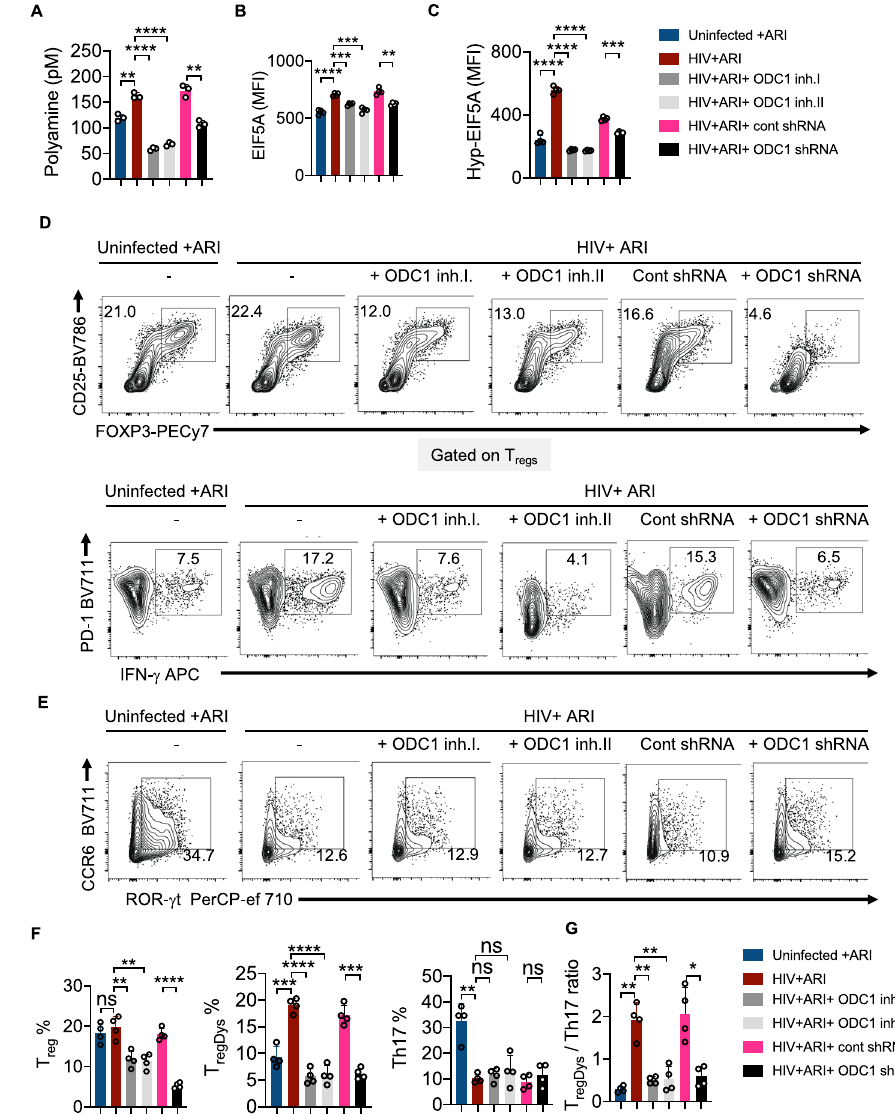
Fig. 5 | HIV-1 infection associated Th dysregulation is dependent on ODC-1 activity. HTOC CD4 + T cells were TCR activated and infected with HIV. ARI (Efa- virenz;50nM),DFMO(ODC-1inhibitorI;2.5mM),POB(ODC-1inhibitorII;100 μ M), Control shRNA lentiviral particles-A with polybrene (2 μ g/ml), and ODC1 shRNA lentiviral particles with polybrene (2 μ g/ml) were added as indicated, 36h post- infection. A Fluorometric polyamine estimation in cell lysates on day 6 post- infection. n =3 independent experiments; Mean values+/ − SD; ** P <0.003; **** P <0.0001; Two-tailed; Welch ’ s t test. B Statistical analysis of EIF5A expression (MFI), and C Statistical analysis of hypusinated EIF5A expression (MFI) from three